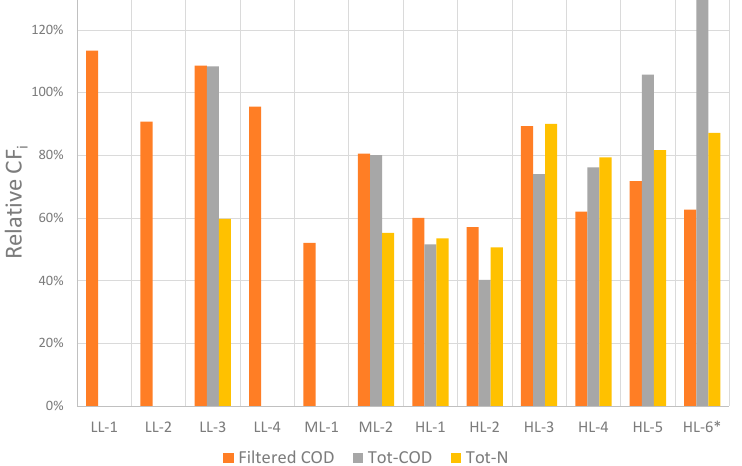
Figure 8. Concentration factors relative to the volumetric concentration factor for filtered COD, Tot–COD and Tot–N.